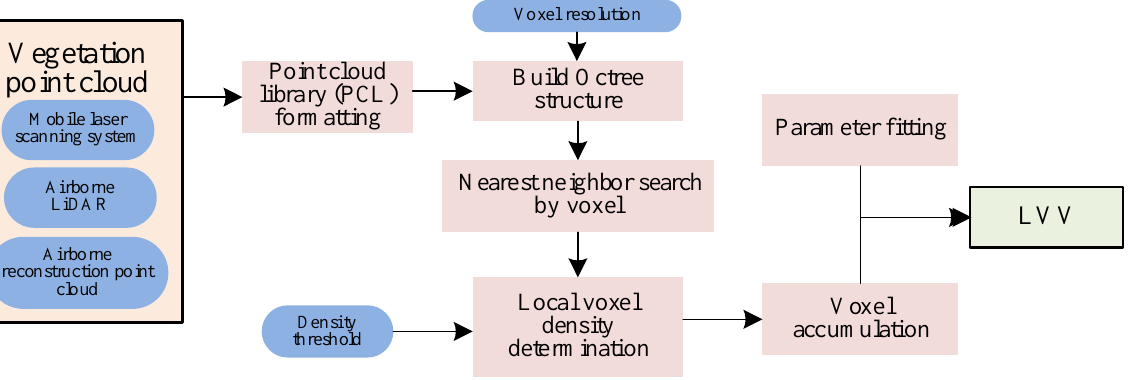
Figure 2. Flow chart of the VO-LVV measurement model based on the voxel method and an oc- tree.